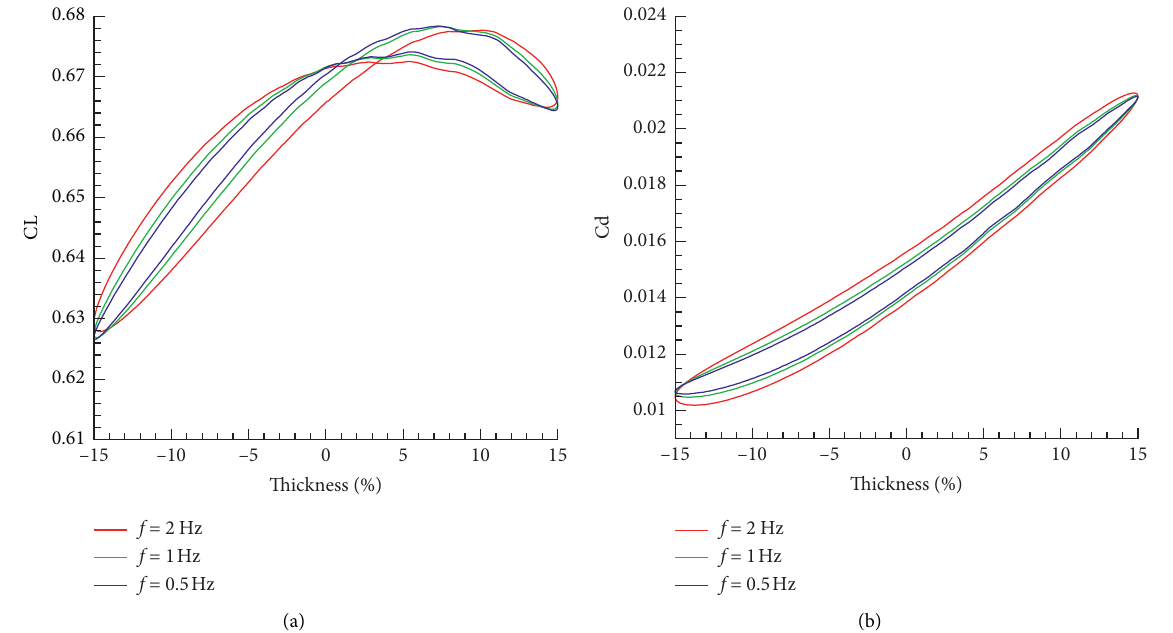
Figure 11: Influence of thickness deformation frequency on aerodynamics ( M � 0.74 and α � 2 ° , CFD).